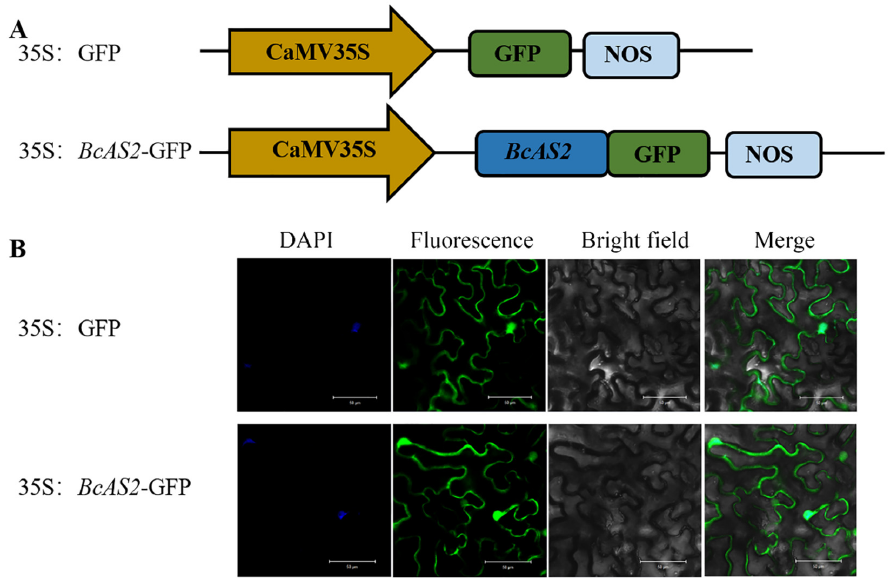
Figure 3. Subcellular localization of BcAS2 . ( A ) The construct of 35S: GFP and 35S: BcAS2 -GFP. GFP: green fluorescent protein; NOS: nopaline synthase gene. ( B ) Transient expression of 35S: GFP and 35S: BcAS2 -GFP fusion protein with DAPI (nucleus specific dye) in tobacco. Scale bars = 50 μ M.